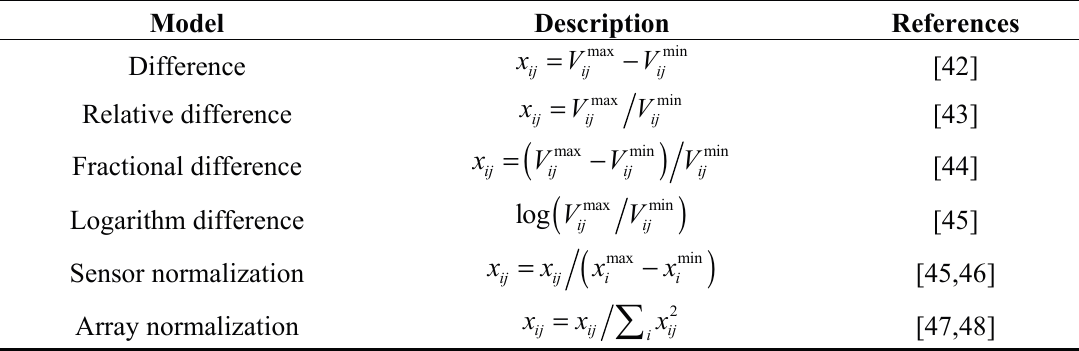
Table 1. Some maximum value feature